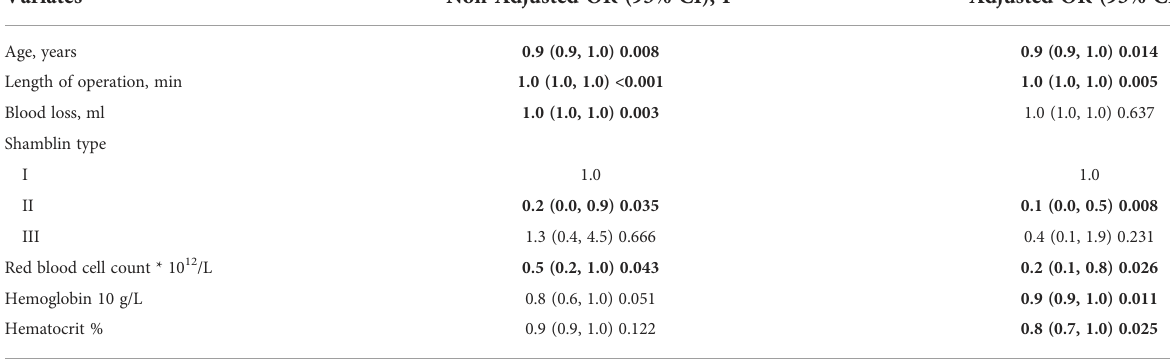
TABLE 5 Univariate and multivariate regression analysis for temporary postoperative complications. Variates